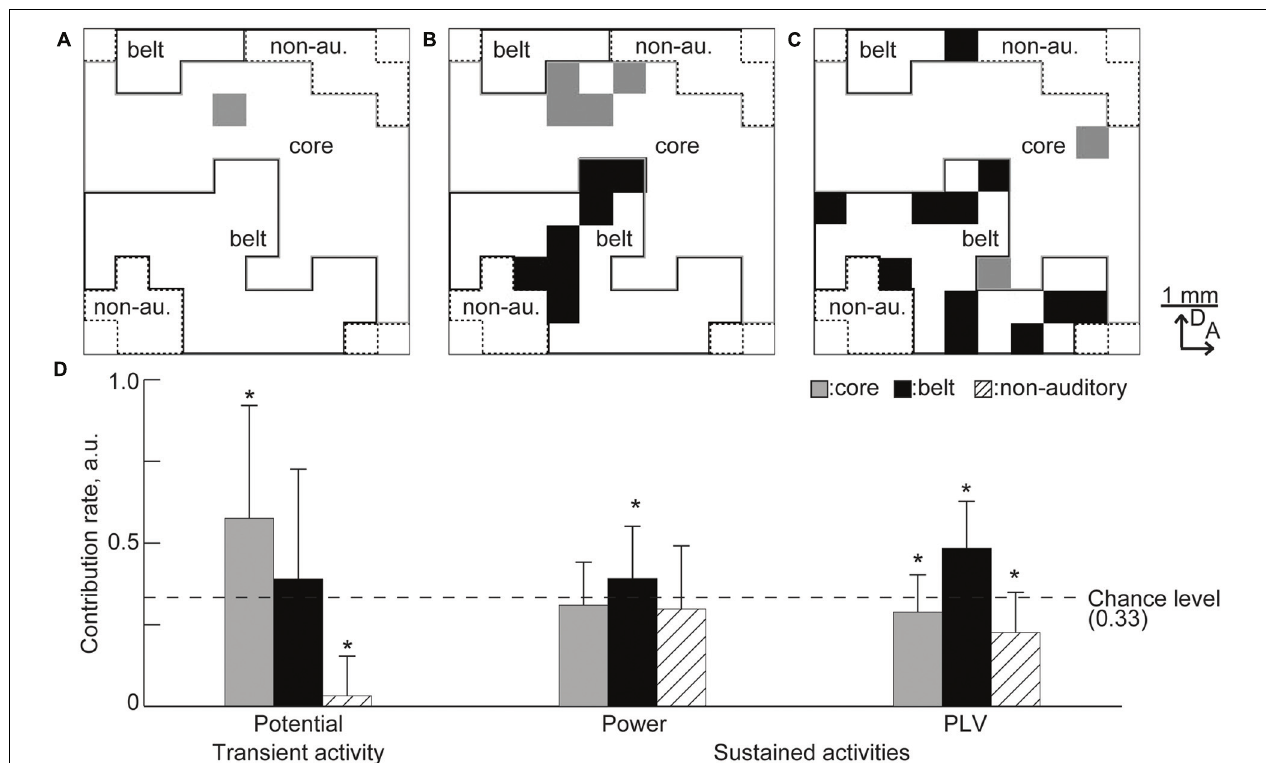
FIGURE 10 | Predominance of the cortical region in the decoding. (A–C) Representative spatial distribution of the remaining recording sites in the decoding from (A) the transient activity, (B) high-gamma power, and (C) high-gamma PLV. Gray and black squares indicate the remaining recording sites. In these representative results, there was no remaining site in the non-auditory region. (D) Contribution rate for each activity. Asterisks indicate that contribution rate was better than the chance level, i.e., 0.33: ∗ p < 0.05 (Mann–Whitney U test with Bonferroni correction for three comparisons).